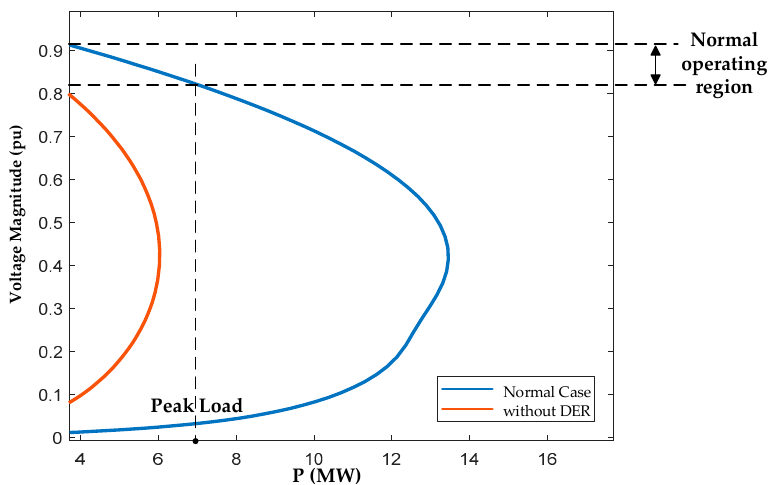
Figure 9. Comparison of the saddle-node bifurcation around the DER hosting capacity (5.89 MW).